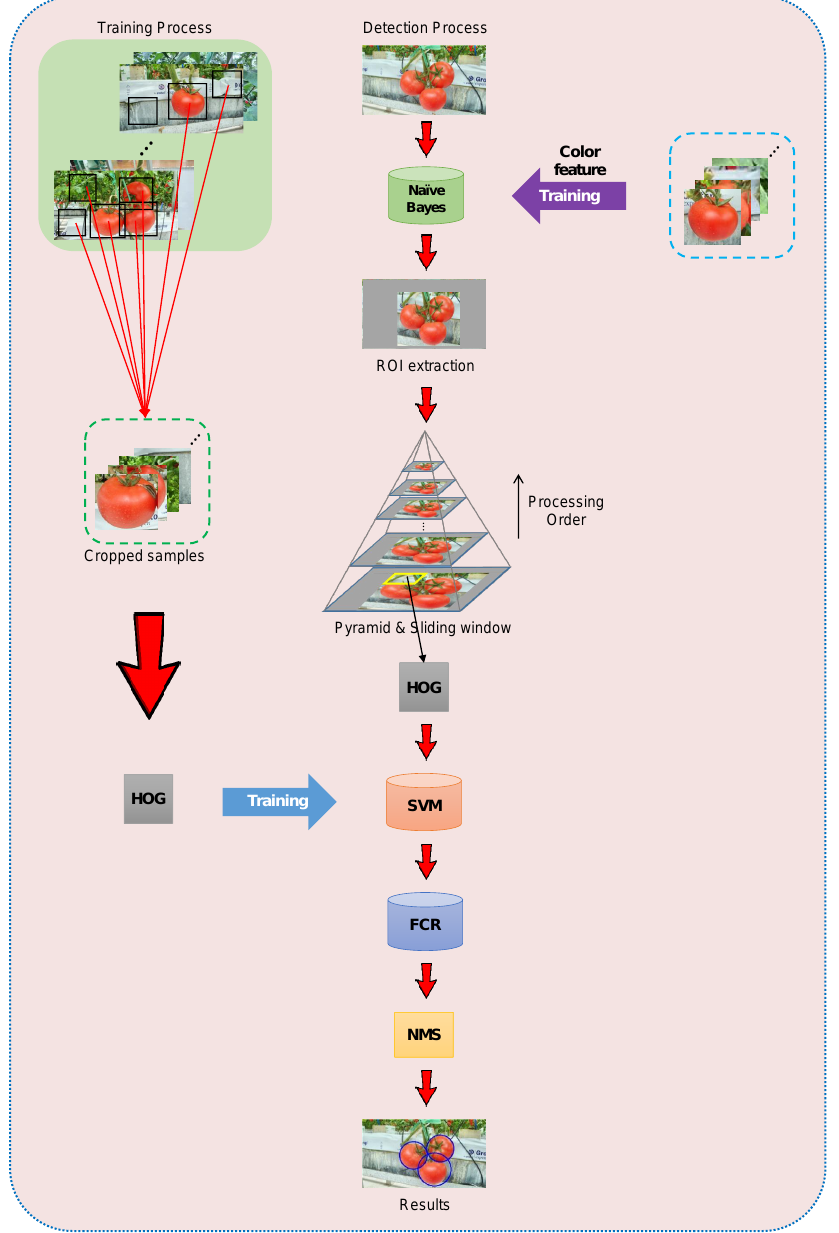
Figure 6. A systematic view of the proposed